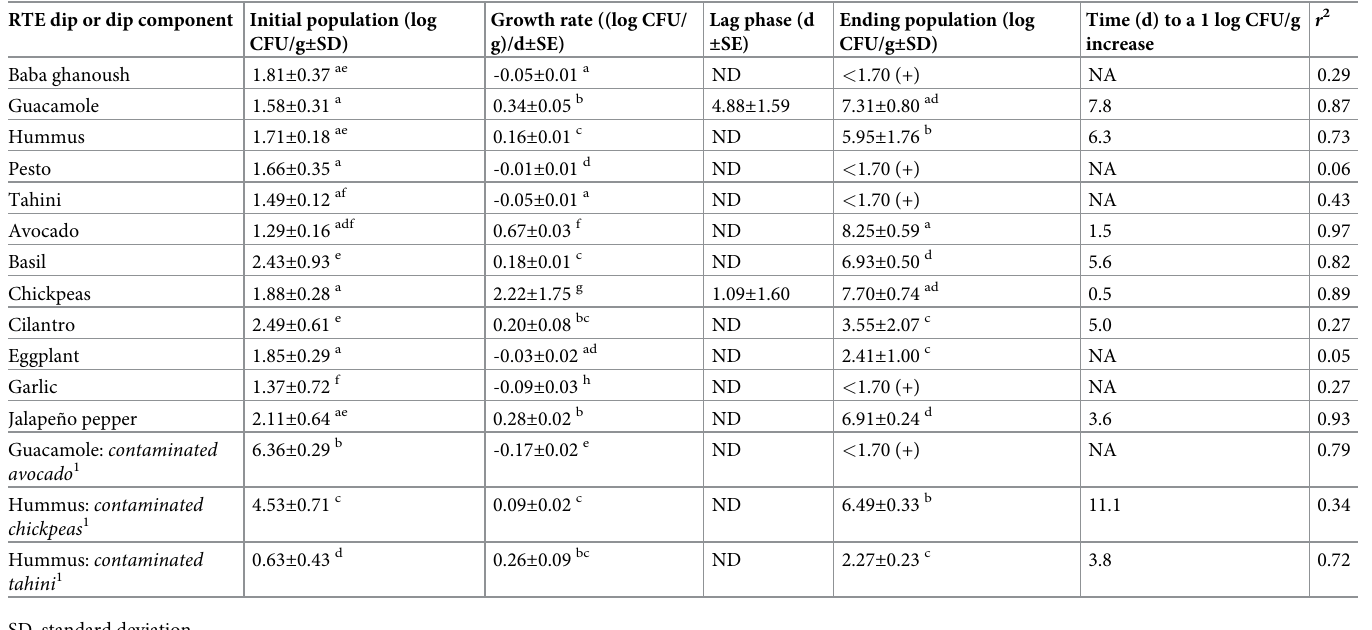
Table 3. Growth kinetics of L . monocytogenes in ready-to-eat (RTE) dips and dip components during 28 d storage at 10˚C. RTE dip or dip component Initial population (log CFU/g ± SD)